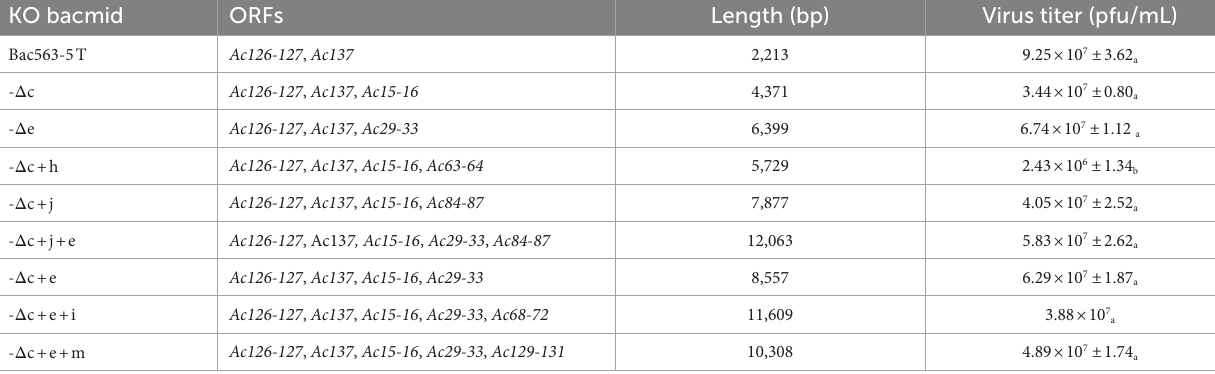
TABLE 3 Summary of the combined deletions of nonessential fragments on Bac563-5 T. KO bacmid ORFs